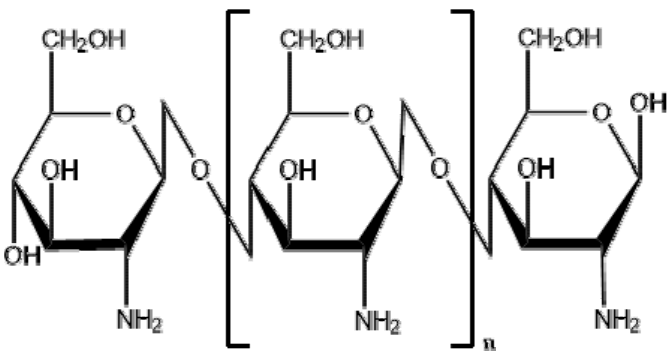
Figure 2. Chemical structure of chitosan [poly-( β -1/4)-2-amino-2-deoxy- D -glucopyranose].